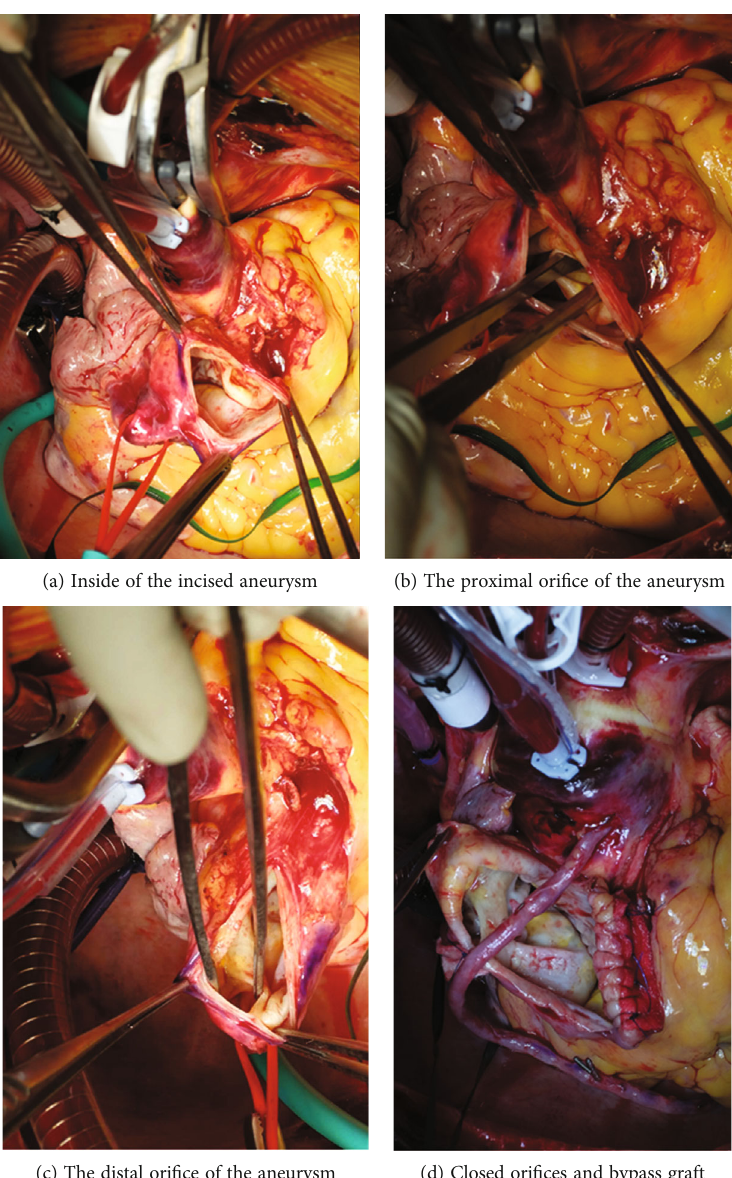
Figure 3: (a – d) Intraoperative images during the